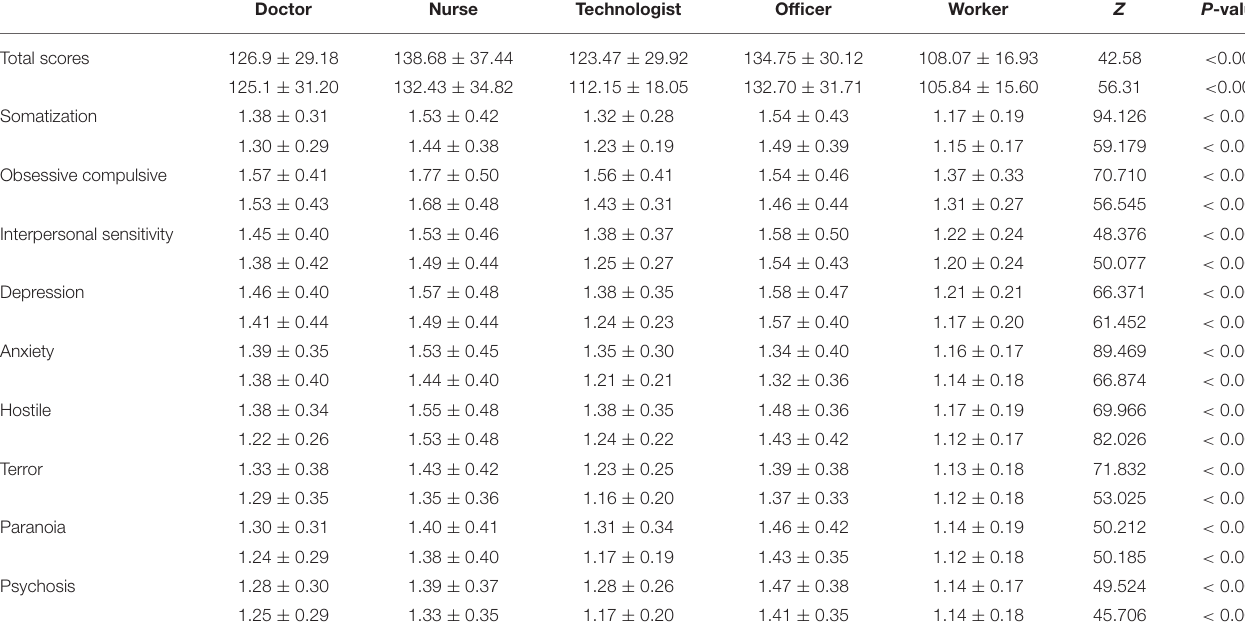
TABLE 7 | Total scores and scores based on each factor of the two SCL-90 evaluations. Doctor Nurse Technologist Officer